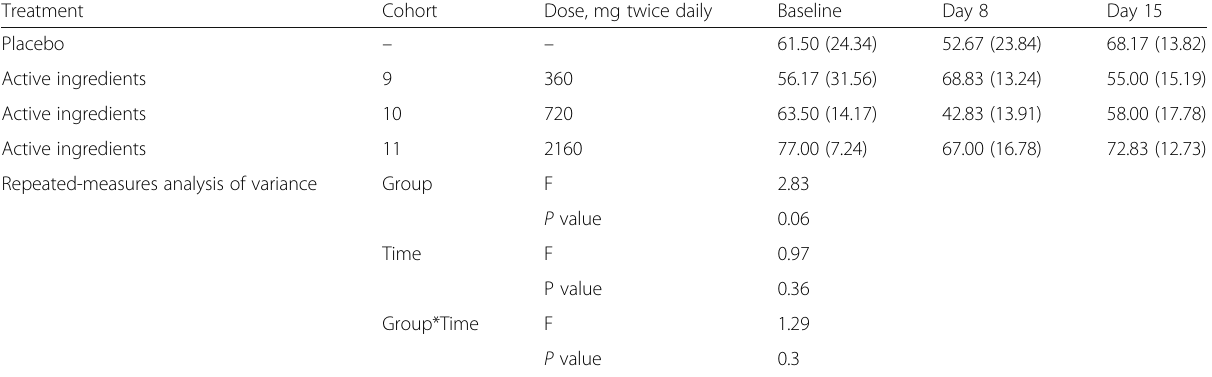
Table 4 Platelet aggregation (%) at different time points